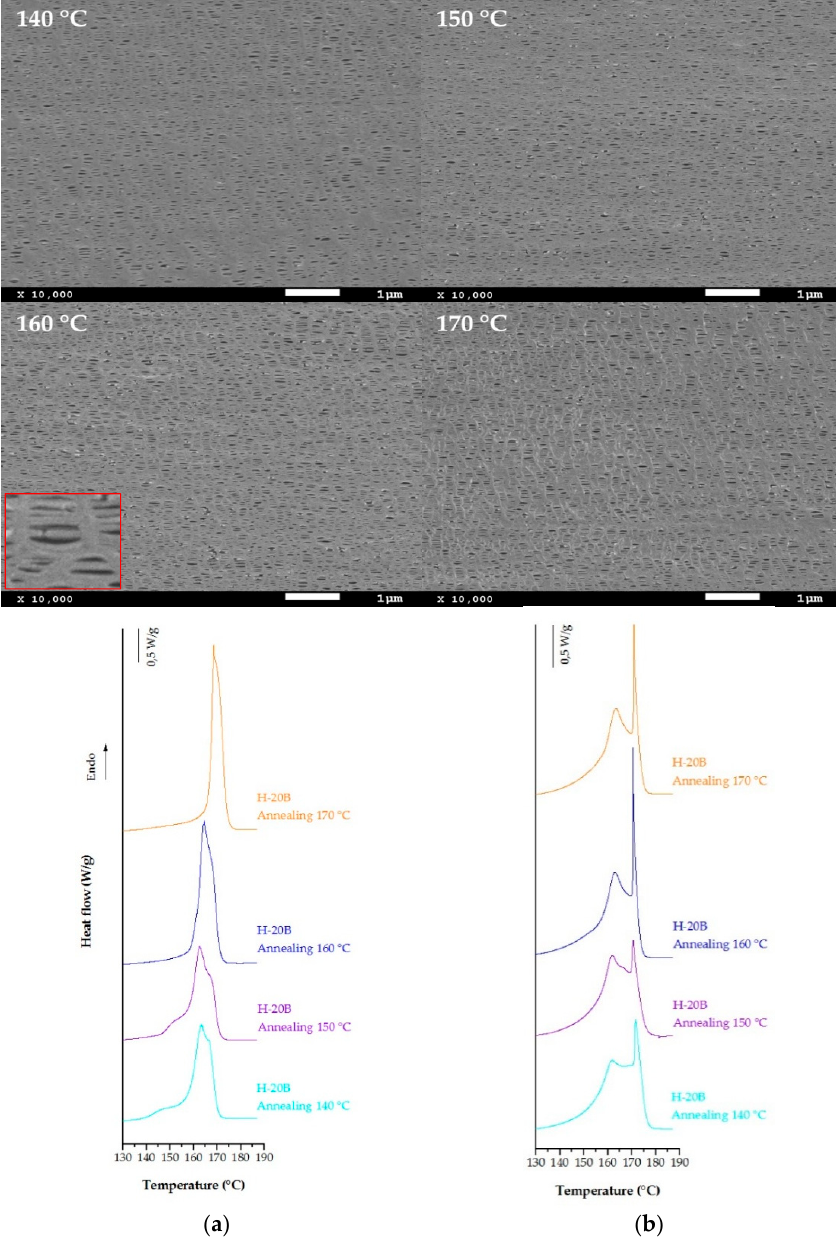
Figure 5. SEM micrographs and DSC thermograms of sample H-20B annealed at different temperatures ( a ) annealed precursor films, and ( b ) membranes (second stretching step at 140 ◦